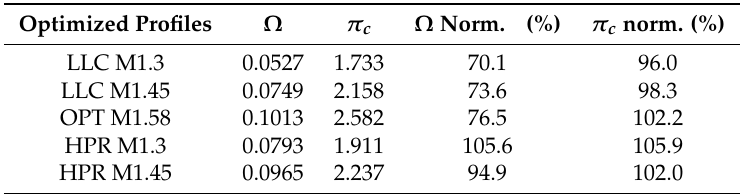
Figure 9. Pareto front of the optimizations, best individuals at other M 1 (Best Opt) and best individuals obtained via ANN (Best ANN). Table 7. Performances of the optimized profiles. LLC, Low Loss Coefficient; OPT, Optimized profile; HPR, High Pressure Ratio; norm., normalized to